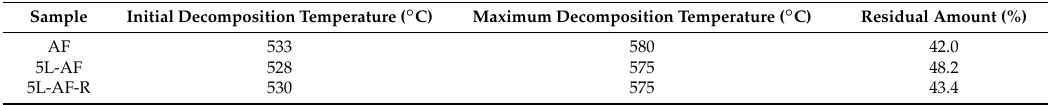
Figure 4. TGA curves of aramid fibers before and after treatment with layer-by-layer self-assembly of L -PDOPA and electrostatic adsorption acidification of silane coupling agents (KH550). Table 2. TGA parameters of aramid fibers before and after treatment with layer-by-layer self-assembly of L -PDOPA and electrostatic adsorption acidification of silane coupling agents (KH550). Sample Initial Decomposition Temperature ( ◦